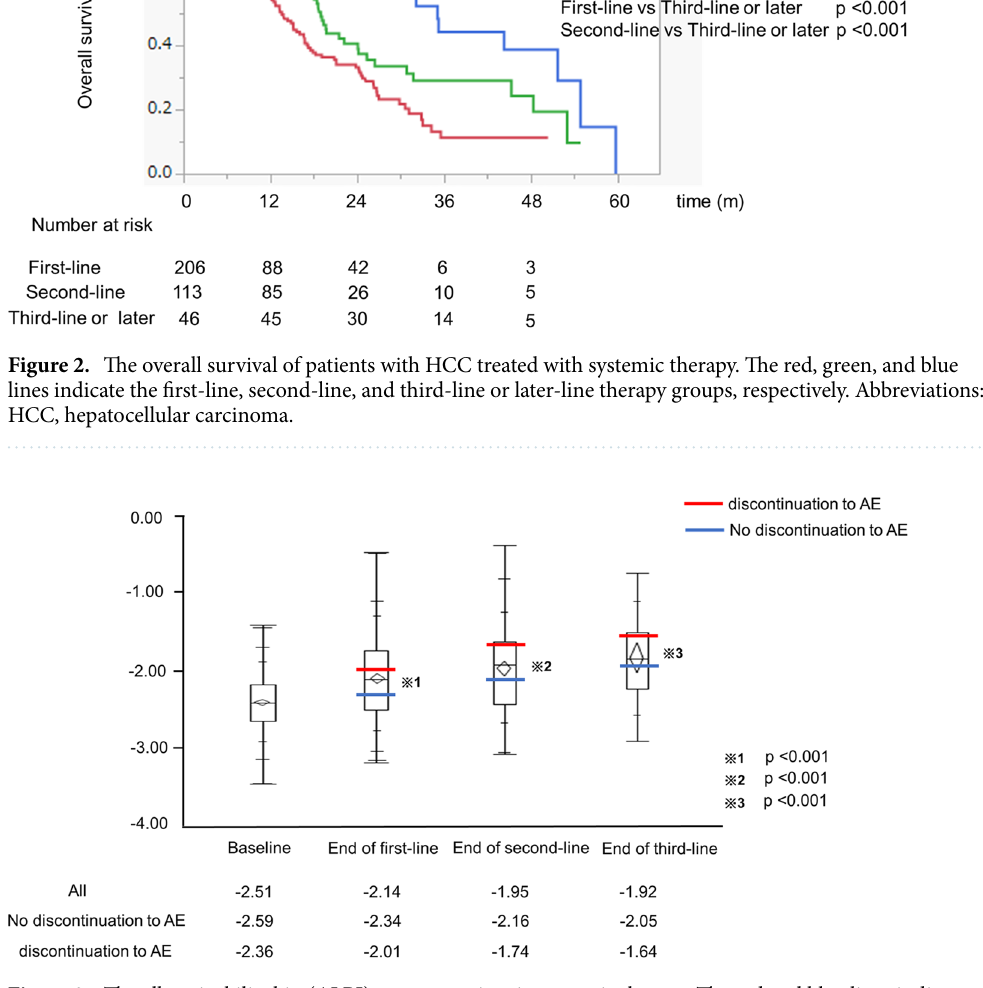
Figure 3. The albumin-bilirubin (ALBI) score over time in systemic therapy. The red and blue lines indicate the treatment discontinuation and no treatment discontinuation due to AEs, respectively. Abbreviations: AE, adverse